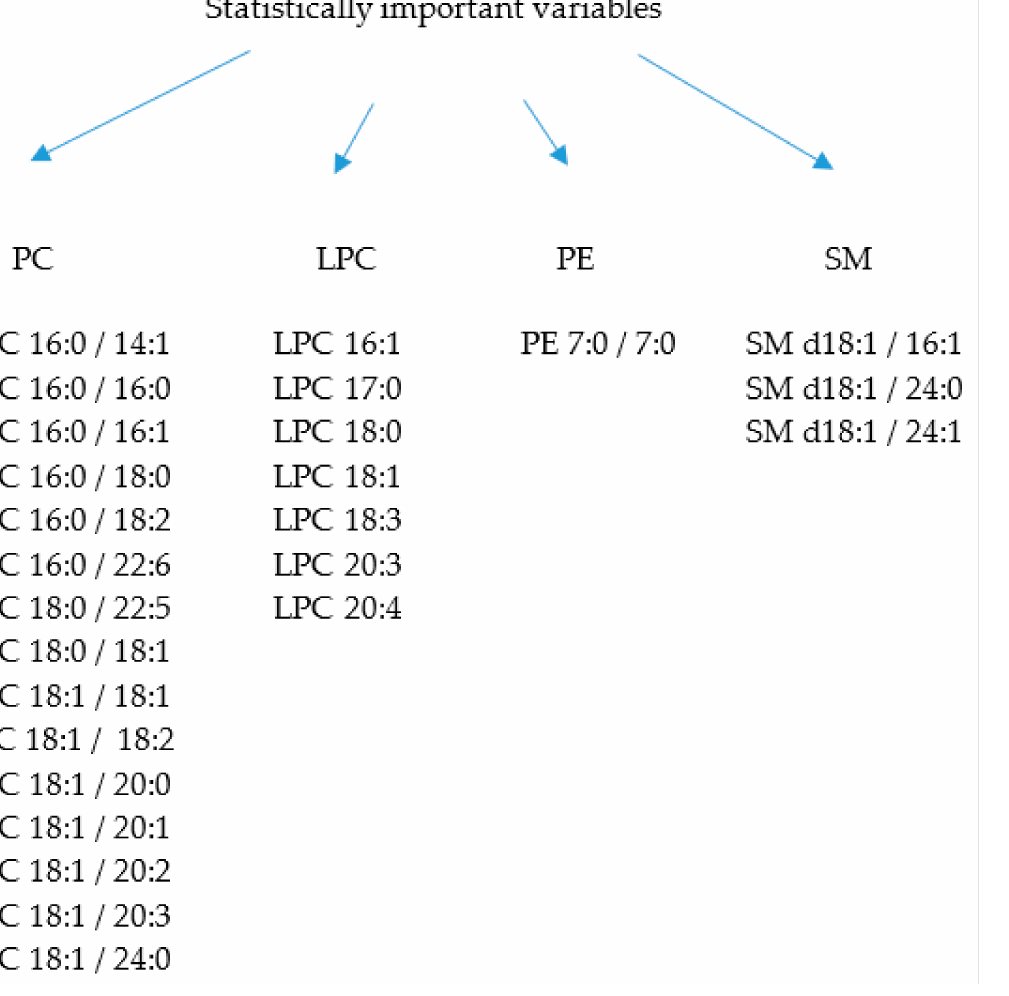
Figure 8. Variables assigned as statistically significant for PCa